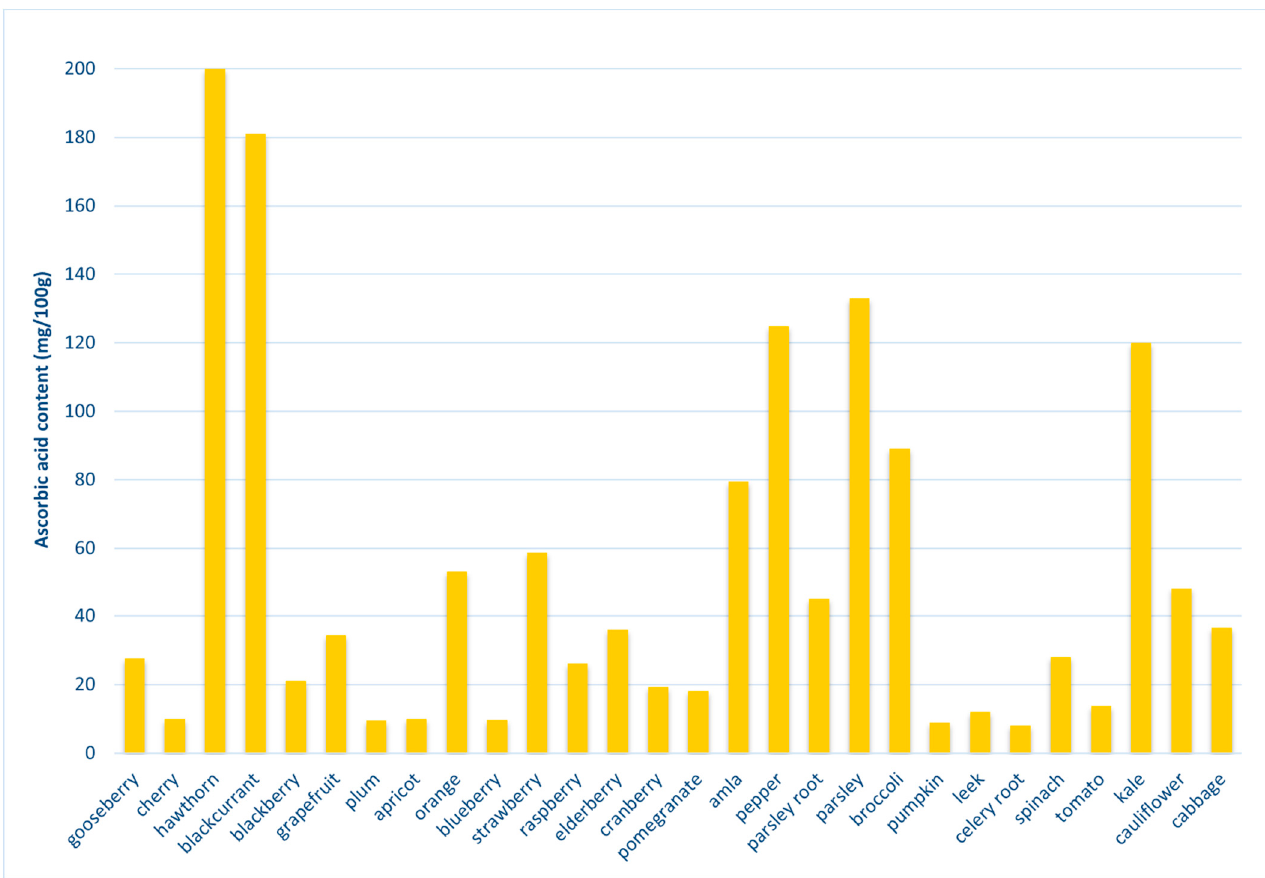
Figure 4. Selected plant sources of ascorbic acid [79,86–89].